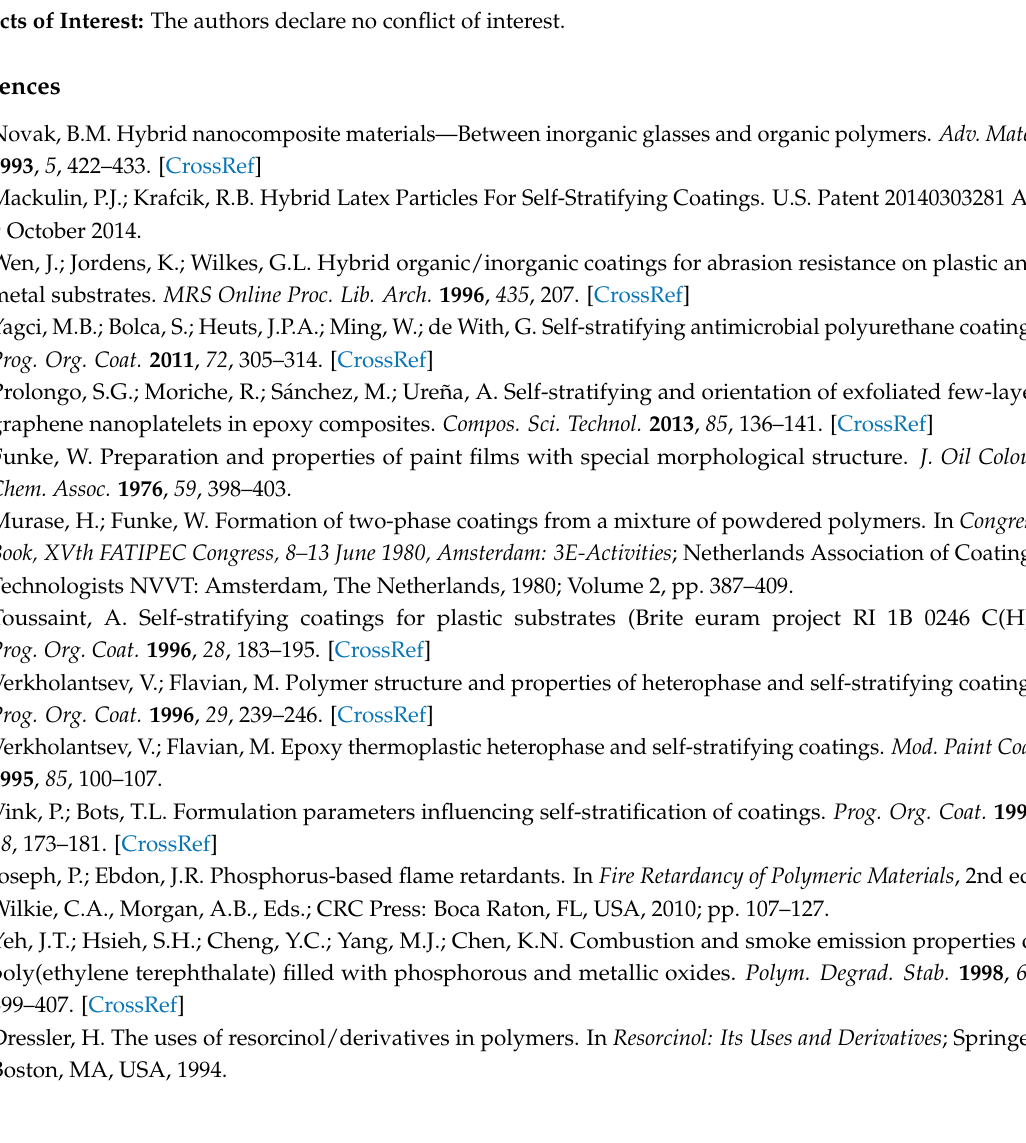
Figure S1: HRR curves obtained with PC and coated PC with the self-stratified epoxy/silicone compositions containing RDP and BDP FR additives at 2.5 wt. % and 5 wt. % (the four curves